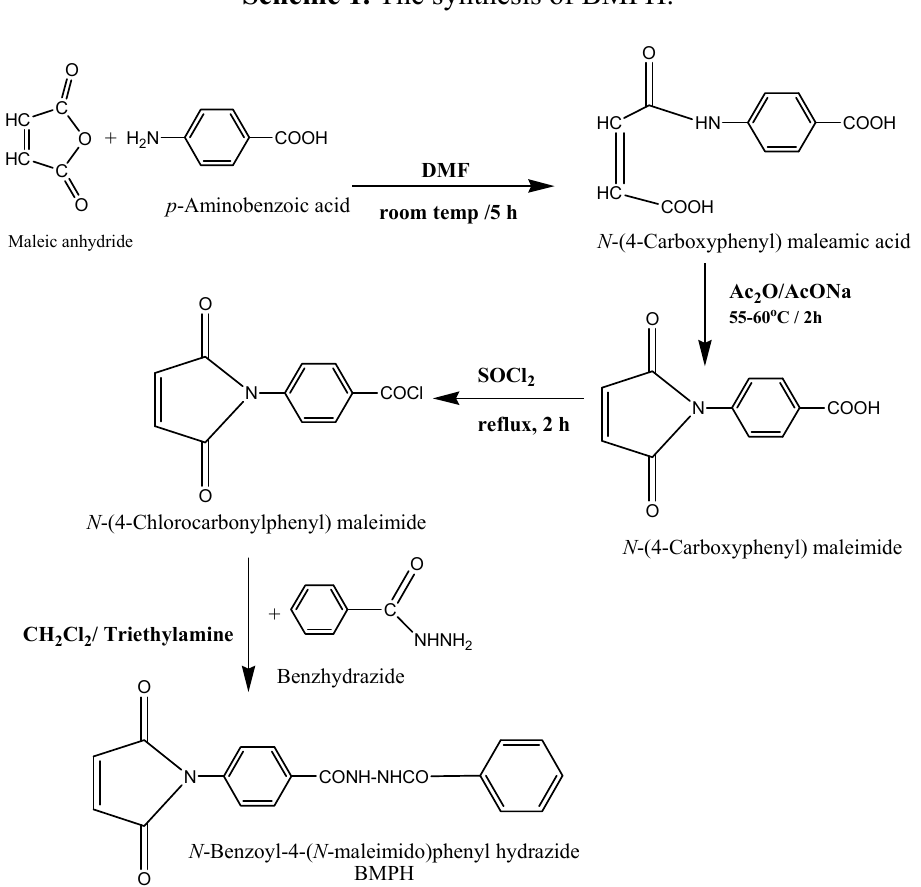
Scheme 1. The synthesis of BMPH.